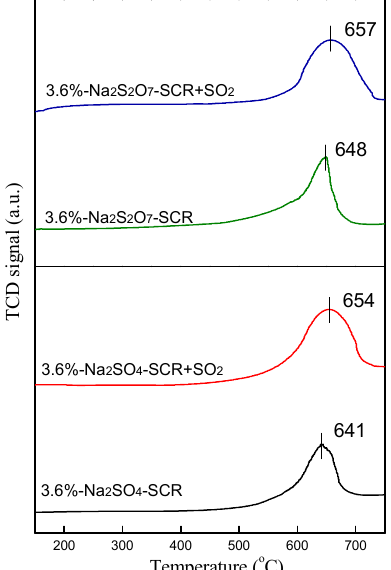
Figure 8. H 2 -TPR profiles of the catalysts in different SO 2 concentration (0 and 1800 ppm).